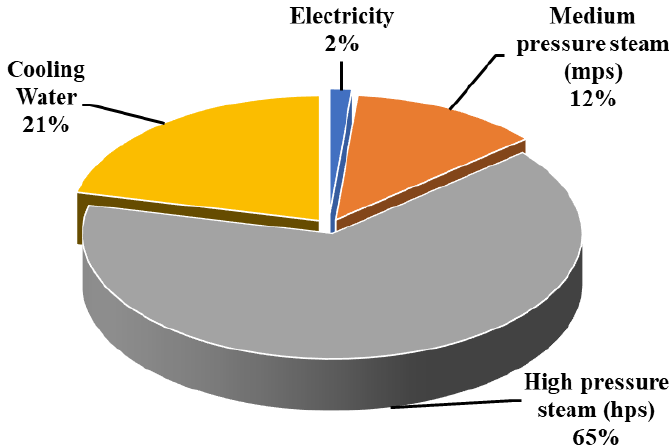
Figure 16. Costs distribution of utilities for glycerol etherification process. Table 7. Materials and utility costs for glycerol etherification process [28,29].